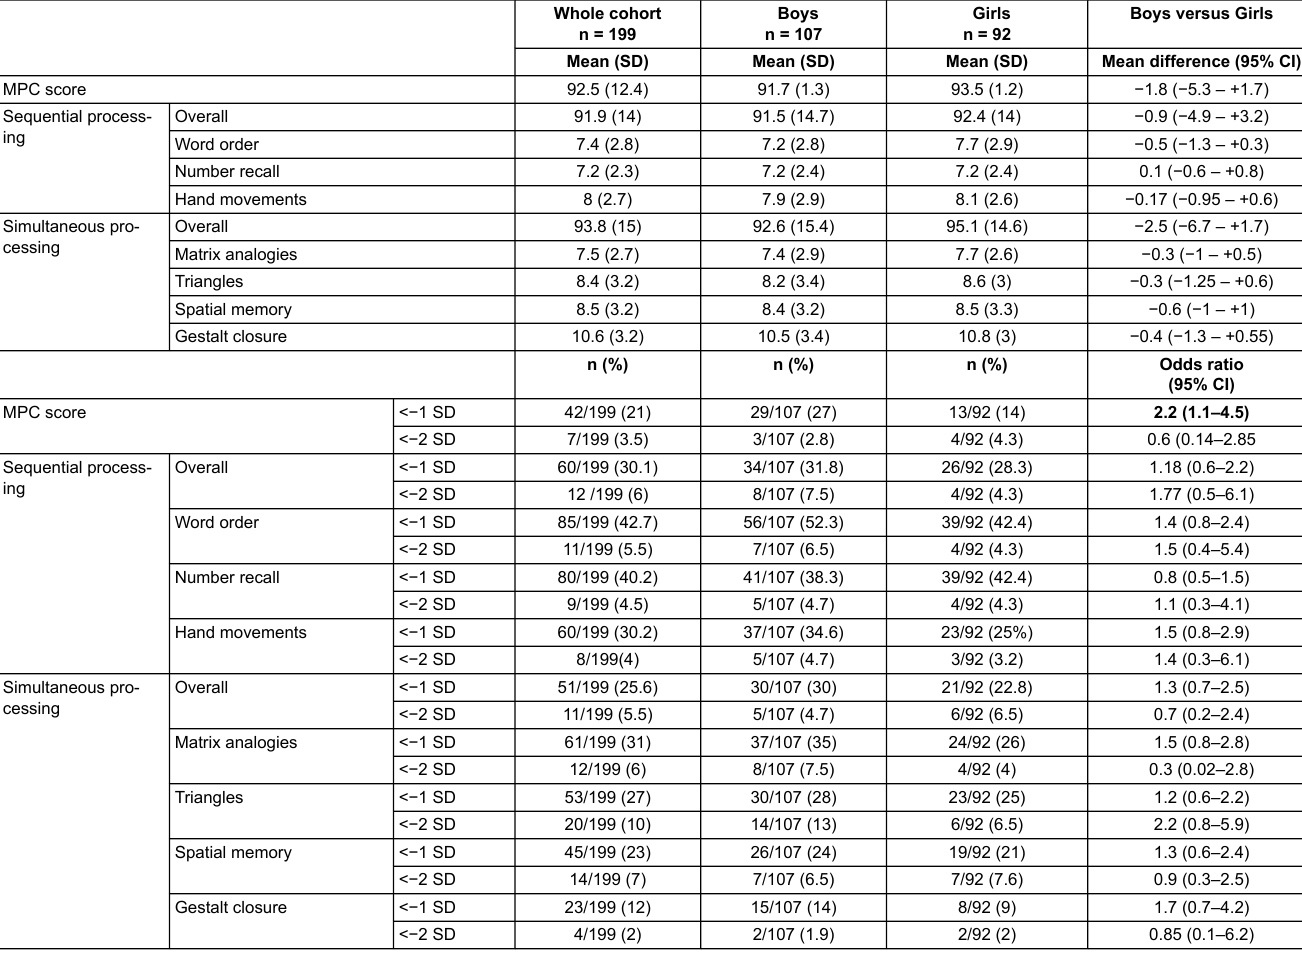
Table 2: Overview of cognitive outcomes with subtest scaled scores by sex grouped by both scales composing the Mental Processing